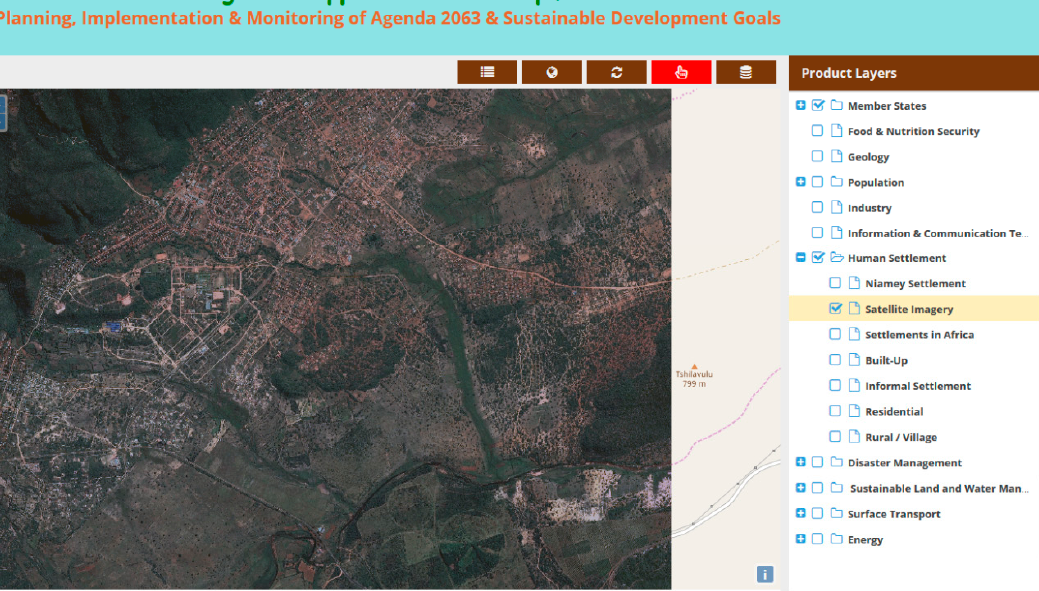
Figure 18. Satellite image data overlays.